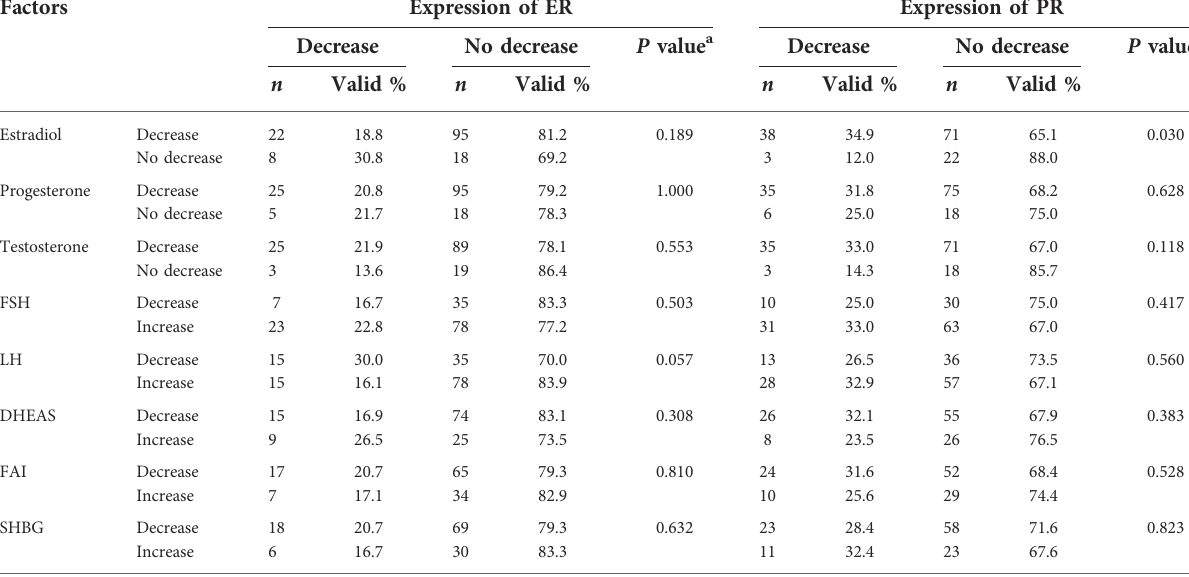
TABLE 3 Analysis of reproductive hormone changes associated with alterations of hormone receptors expression in all